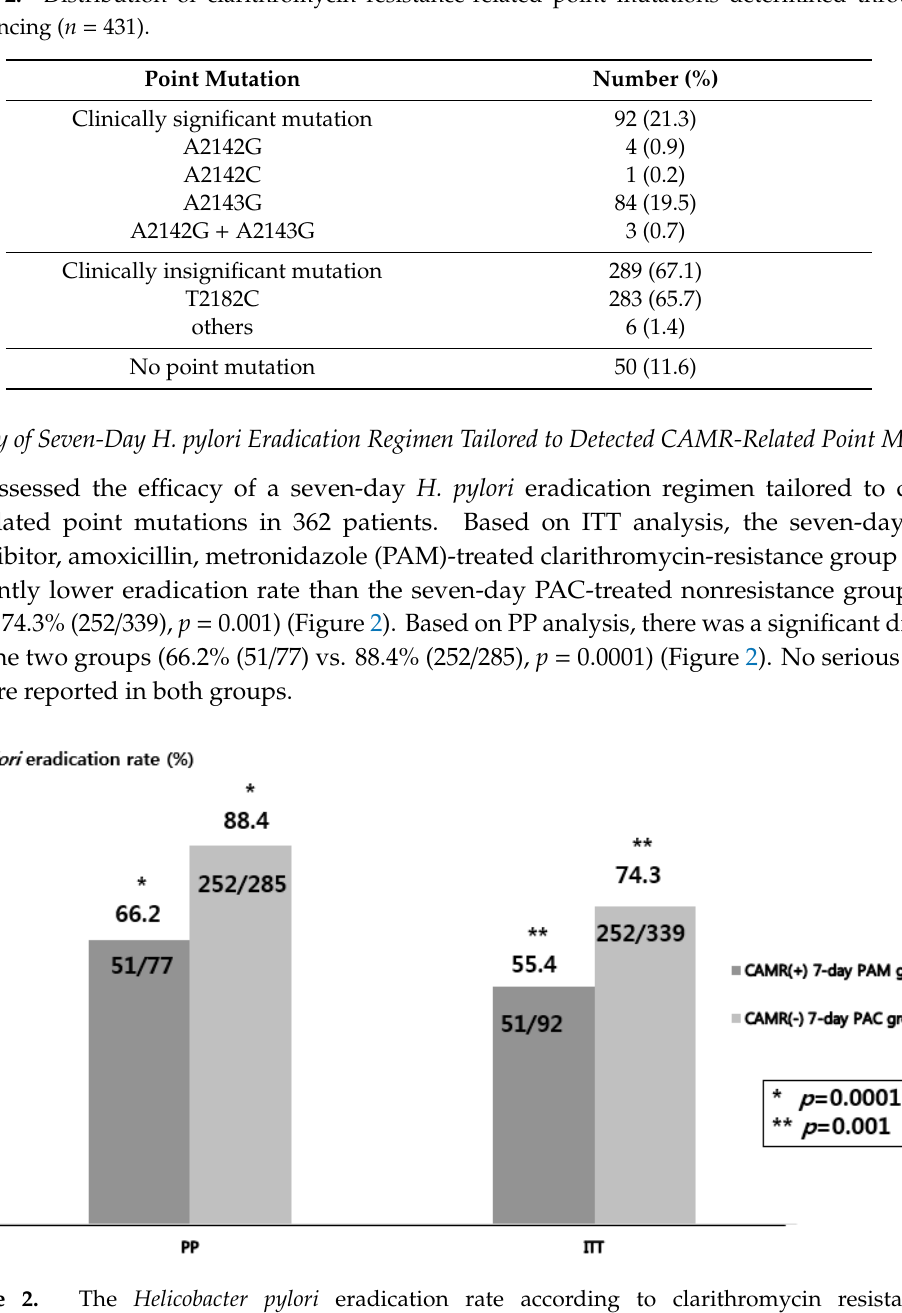
Figure 2. The Helicobacter pylori eradication rate according to clarithromycin resistance.